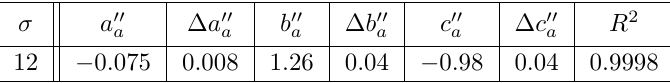
= 7 . 5 . ∆ a 00 are the uncertainties of parameters , ∆ b 00 , ∆ c 00 m a a a